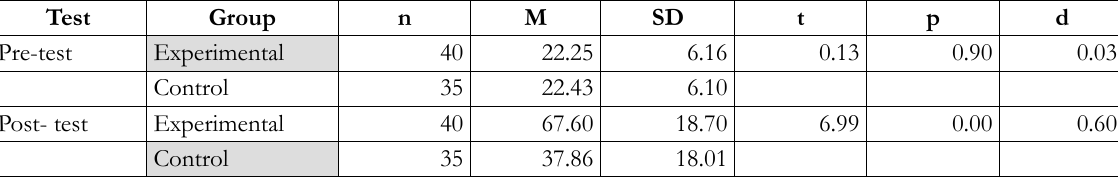
Table 3. T-test results of the pre-tests and post-tests of both the EG and CG (*significant at p < 0.05) Table 3 shows no statistically significant differences between pre-test of EG (M = 22.25, SD = 6.16) and CG (M = 22.43, SD = 6. 10) (T-test: t(73) = 0.13; p > 0.05) with Cohen d = 0.03. The lack of